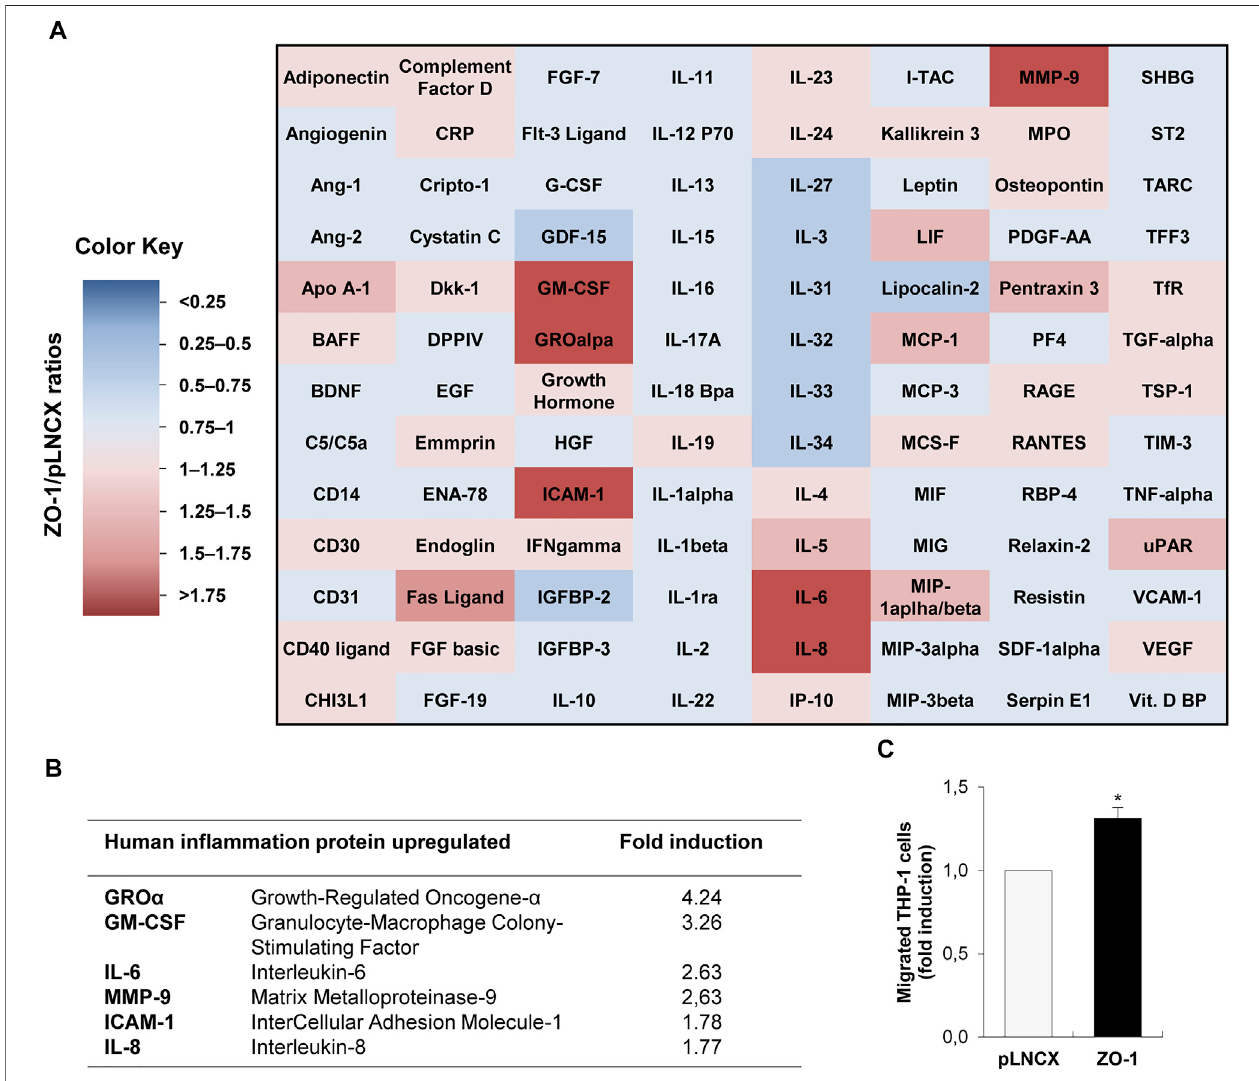
FIGURE 1 | ZO-1 modulates in vitro in fl ammatory chemokine secretion. (A) Cytokine and chemokine secretion analyzed by cytokine-array in conditioned medium from BEAS-2B cells transfected with ZO-1 expression vector (ZO-1) or the corresponding pLNCX control vector (pLNCX). The heat map colors correspond to the pLNCX / ZO-1 cytokine and chemokine ratios. Downregulated (blue) and upregulated (red) proteins in conditioned medium from ZO-1 cDNA BEAS-2B cells are represented. (B) Summary table of most modulated chemokines according to the analysis of the cytokine/chemokine array presented in (A) . (C) Analysis of chemotactic migration of THP-1 monocytic cell in response to conditioned medium from ZO-1 cDNA BEAS-2B cells (conditioned medium of pLNCX empty vector transfectants is used ascontrol).Data areexpressed asfold induction relative to thecontrolcondition inthree independent experiments. Mean ± SEM; n (cid:2) 3; **p < 0.01.